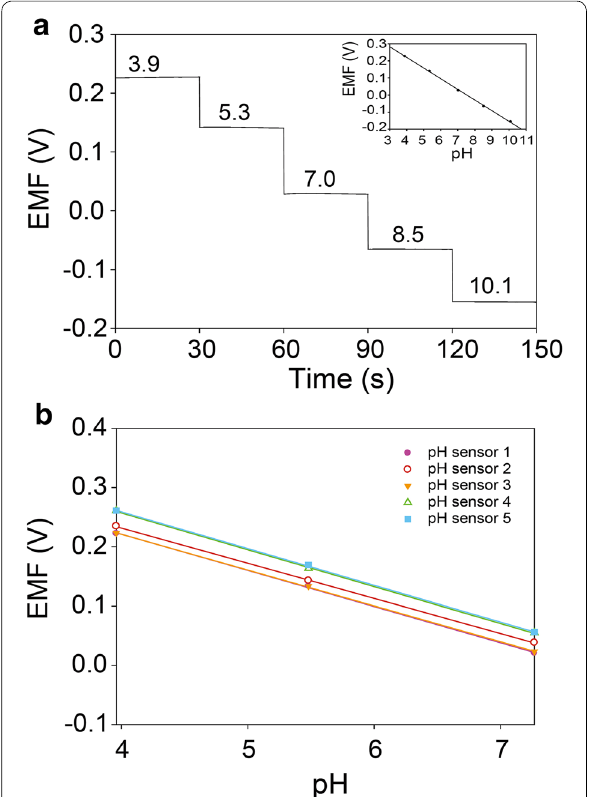
solutions of pH 3.9 ‒ 10.1. Inset is a plot of EMF signals versus pH. b Reproducibility test of pH sensor measured in buffered solution of pH 3.9, 5.5, and